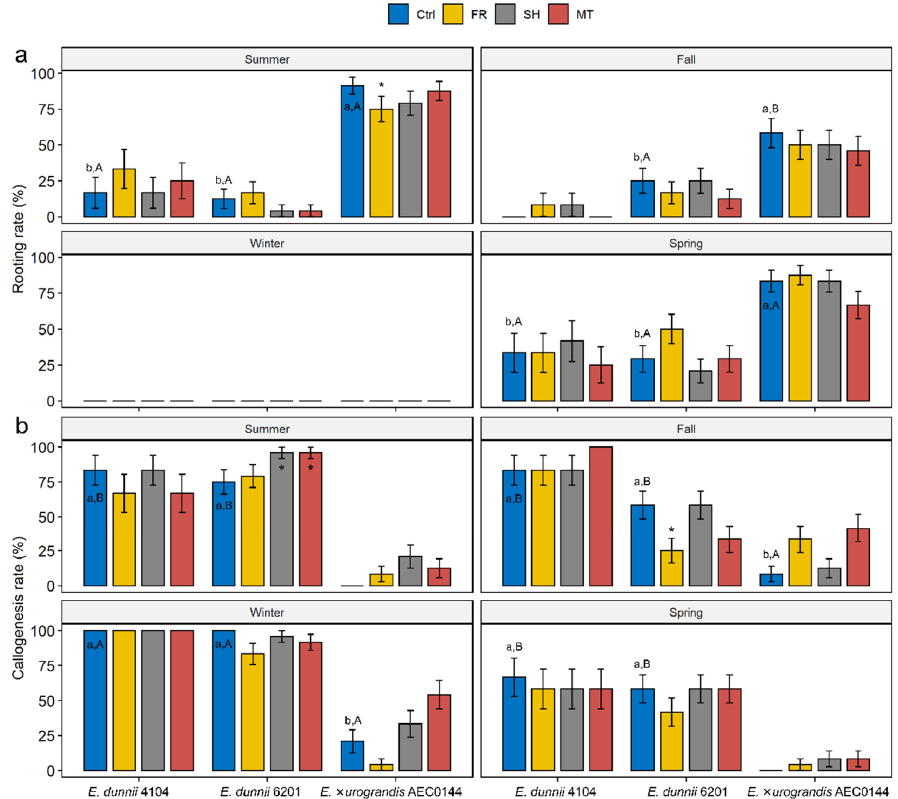
Figure 2. Developmental outcomes of Eucalyptus dunnii 4104 and 6201 (hardR clones) (at 21 days post ‐ excision) and E. × urograndis AEC0144 (easyR) cuttings (at 14 days post ‐ excision). ( a ) Relative frequency (%) of rooted cuttings and ( b ) cuttings with calli, obtained from mini-stumps under control (Ctrl), far ‐ red ‐ enriched (FR), shade nets (SH), and mini ‐ tunnel (MT) conditions. Bars represent mean ± SEM. Asterisks indicate significant differences in the treatments in comparison to the Ctrl (* p ≤ 0.05, Dunnett’s test). Different lowercase and uppercase letters indicate significant divergence when comparing Ctrl results across clones in the same season and Ctrl results across seasons in the same clone, respectively (ANOVA, Tukey’s test, p ≤ 0.05).